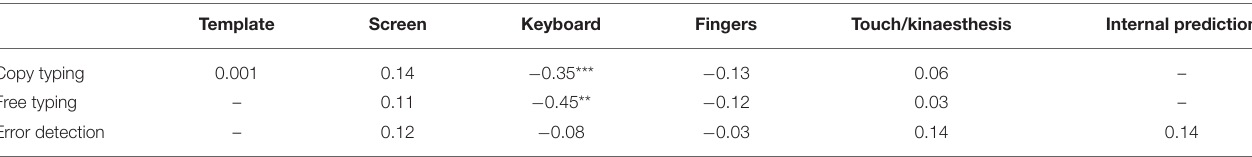
TABLE 5 | Correlations between the number of fingers used by idiosyncratic typists and the extent of attention to/use of different sources of information during copy typing, free typing and error